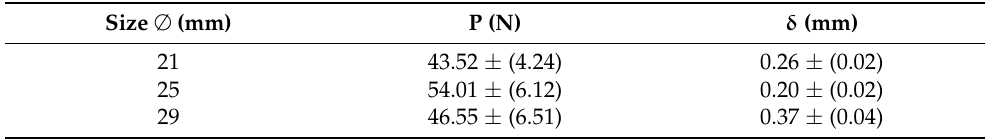
Table A4. Mean values of maximum load and corresponding displacement obtained through the three-point bending test procedure before the failure of the sample produced through the modified deposition